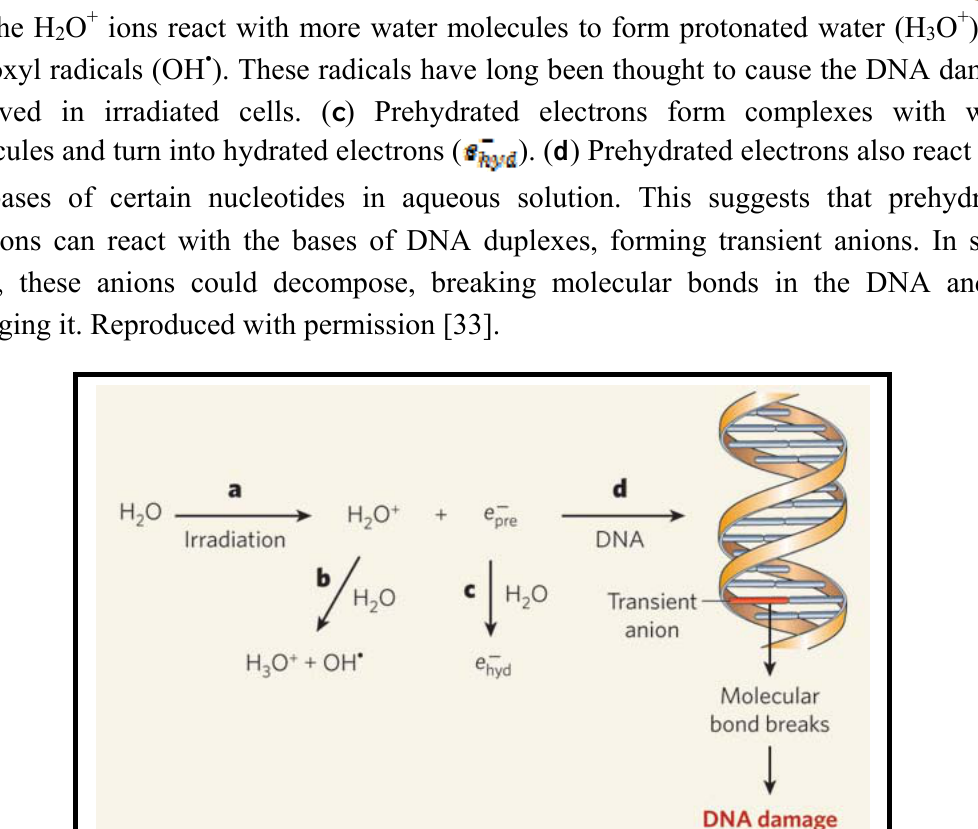
O + ions and free electrons. After 2